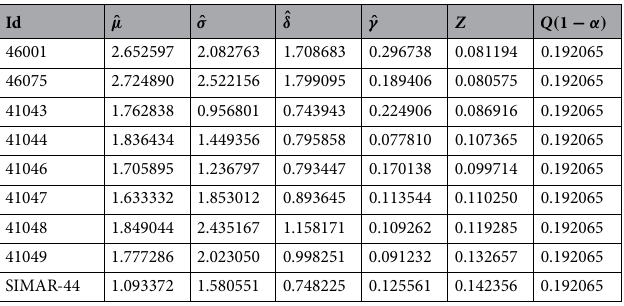
Table 2. Parameter estimation and Kolmogorov-Smirnov test results.